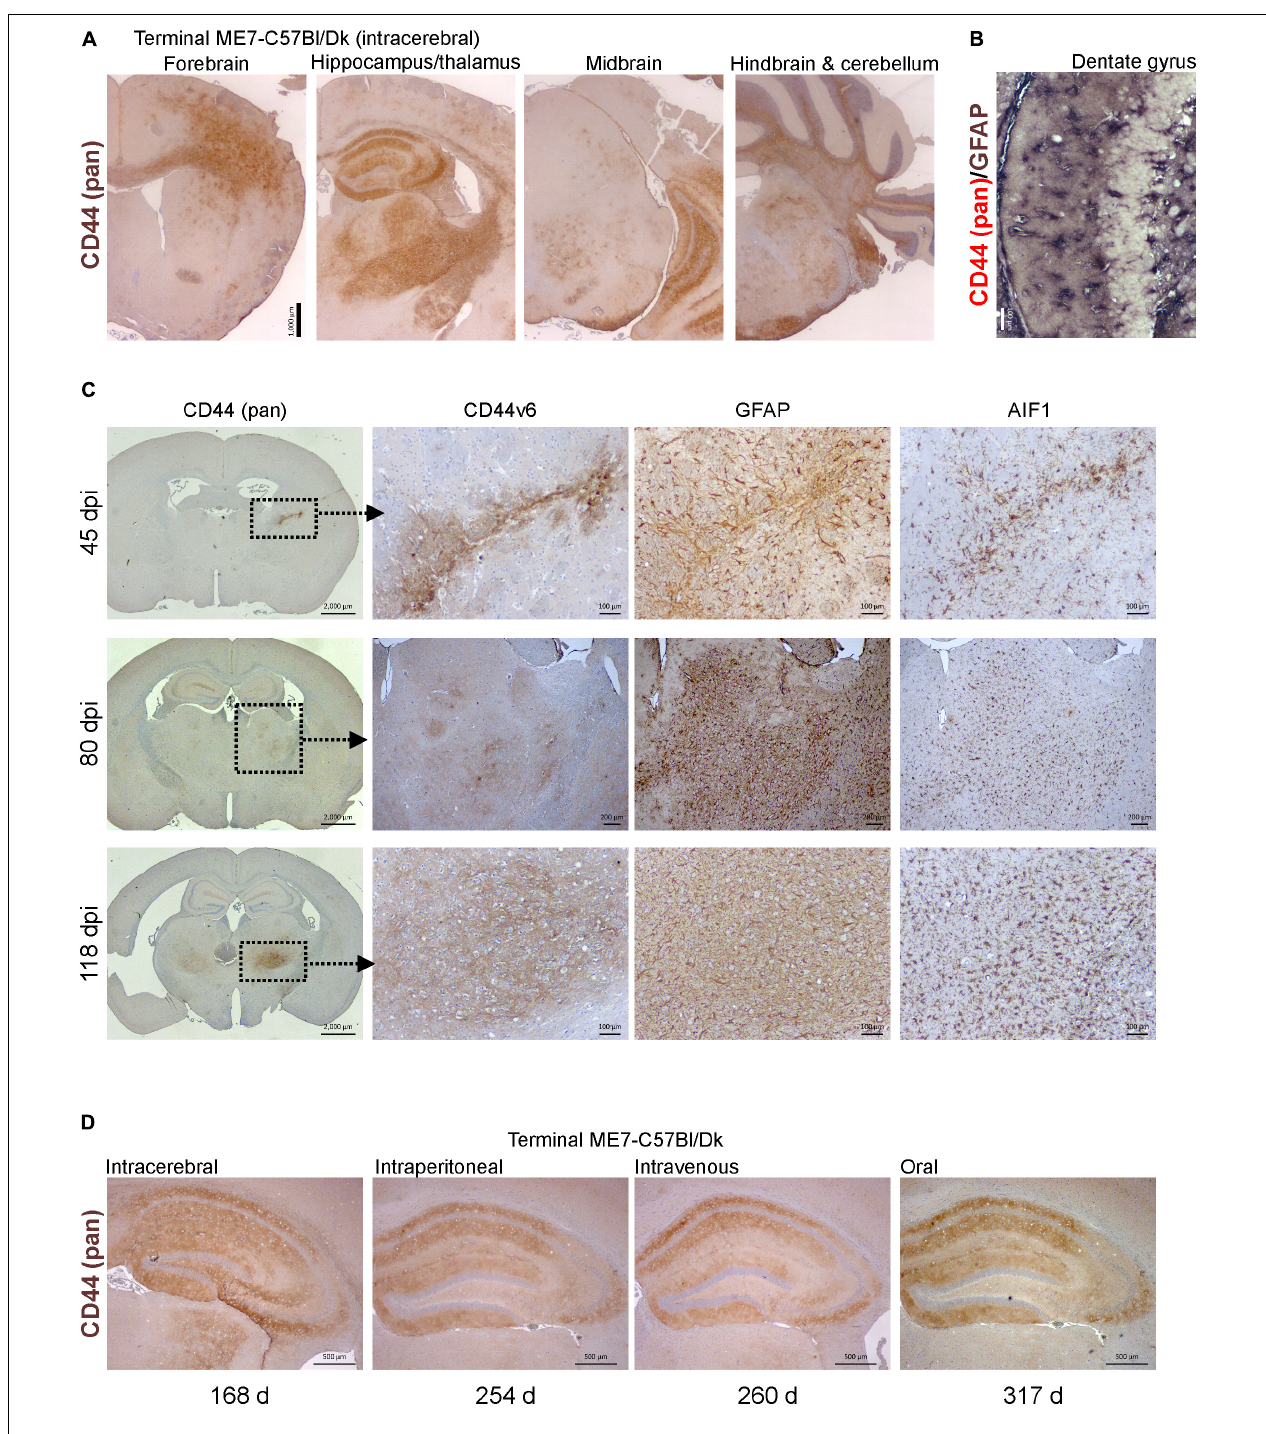
FIGURE 7 | CD44 expression is upregulation in the brain during prion disease. (A) C57Bl/Dk mice were injected intracerebrally with ME7 scrapie prions and brains collected at the terminal stage of disease and immunostained to detect CD44. Scale bar = 1,000 µ m. (B) Dual immunostaining for CD44 and GFAP suggested a correlation in their patterns implying an astrocyte origin. Scale bar = 100 µ m. (C) C57Bl/Dk mice were injected intracerebrally with ME7 scrapie prions, brains were collected at intervals after infection and immunostained to detect CD44, CD44v6, GFAP and IBA1. Analysis of brains from 45, 80, and 118 days post injection (dpi) shows the progressive increase in expression from the needle-track, injection side thalamus and bilateral spread, respectively. Images are representative of N = 4 mice/group. Scale bars = 2,000, 100, or 200 µ m as indicated. Upregulation of CD44 coincided with astrocyte (GFAP) and microglial (AIF1) responses. (D) CD44 pattern in terminal mouse brain following intracerebral, intraperitoneal, intravenous or oral ME7 infection reveals similar distribution of immunostaining irrespective of the route of exposure. Survival times (days) indicated. Images representative of N = 6 mice/group. Scale bars = 500 µ m.